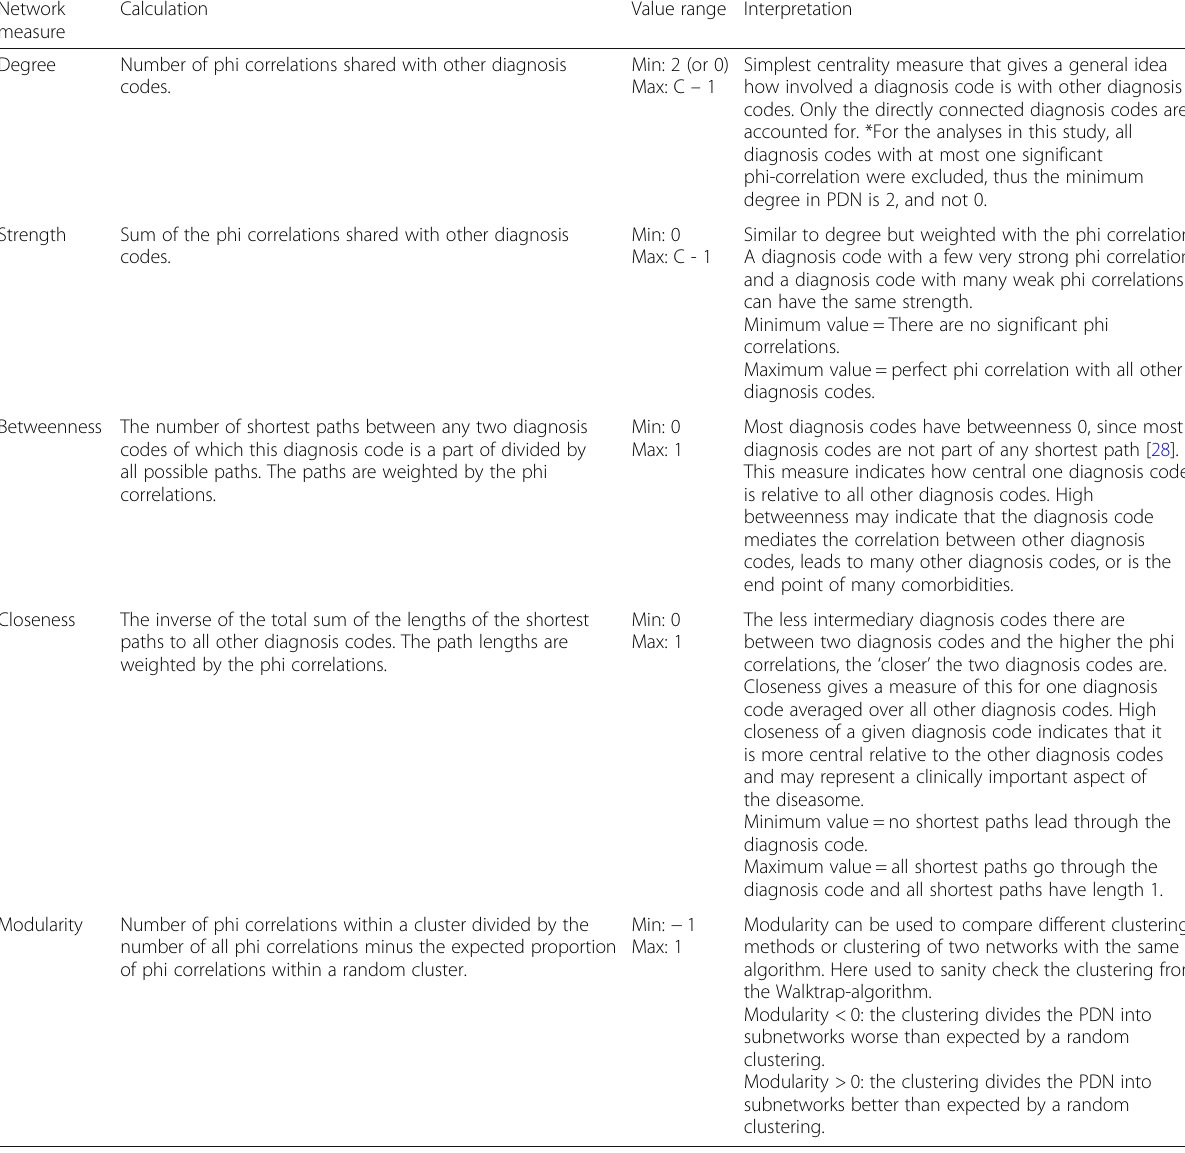
Table 3 Summary of the four reported connectivity measures from the PDNs. Degree, betweenness, closeness, and strength are defined for single diagnosis codes, while modularity is defined for the whole PDN based on a given clustering. For mathematical and formal definitions see [28] and [26]. Note that the C in the value range column stands for the total number of all